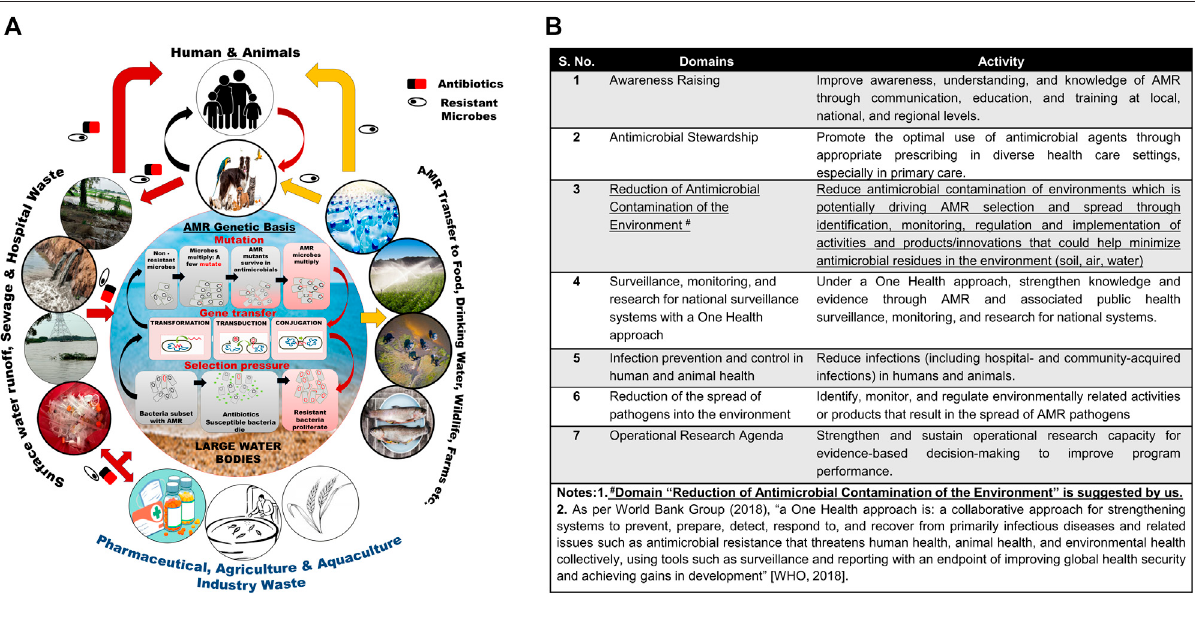
Frontiers in Environmental Science |